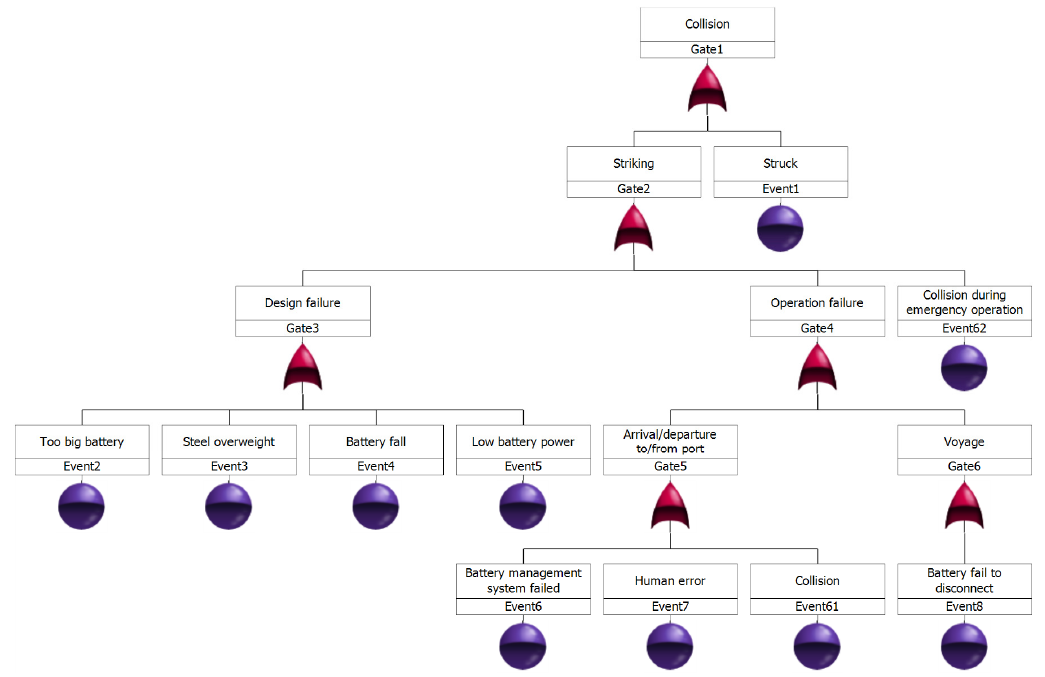
Figure 7. Fault tree analysis on hazard associate with collision.